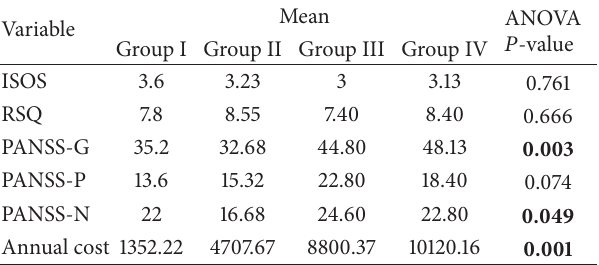
Table 3: Means scores of ISOS, RSQ, and PANSS subscales in the four engagement groups are reported. In the last column ANOVA significance values are listed.